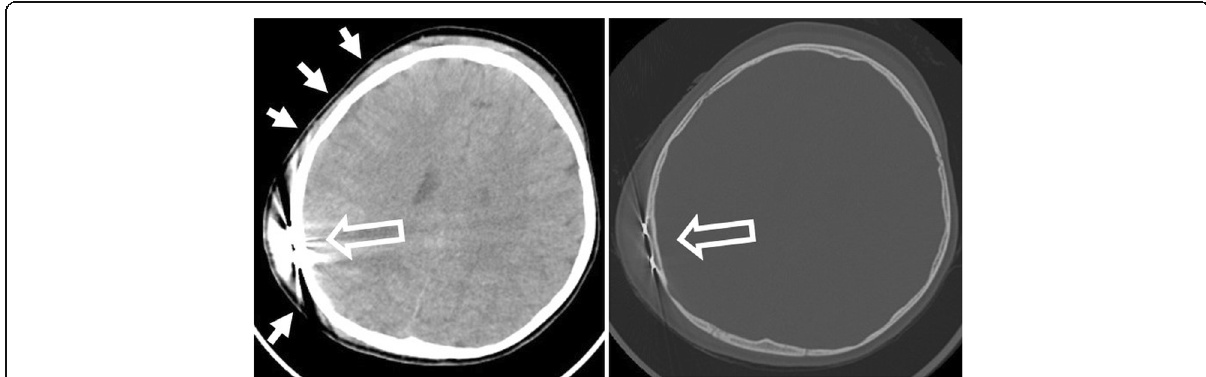
Fig. 35 A 4-year-old male patient, with pain and insufficient hold of the speech processor after running into his brother. CT axial soft kernel image (left image) shows marked hematoma (arrows) in the skin at the frontal bone and temporal bone around the implanted magnet (hollow arrow). No intracranial bleeding. CT bone kernel axial image (right image) shows intact bone. The magnet is in the correct